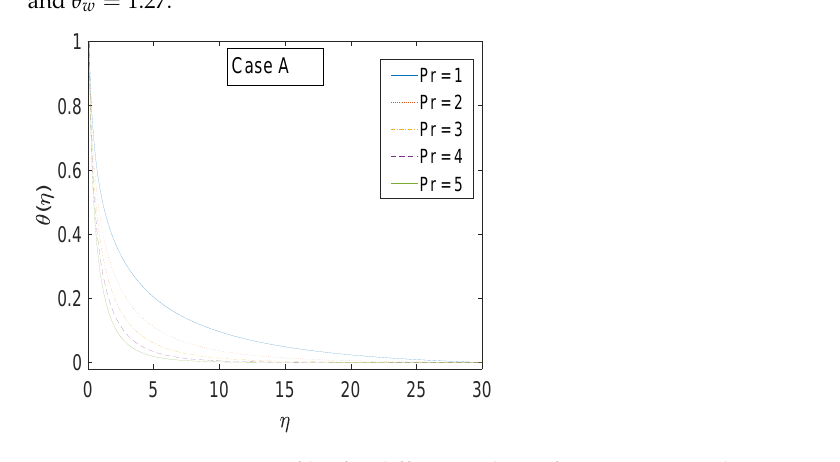
Figure 6. Temperature profiles for different values of parameter Pr when λ = 0.8, (cid:101) = 0.5, m = 0.1 and θ w = 1.27 .